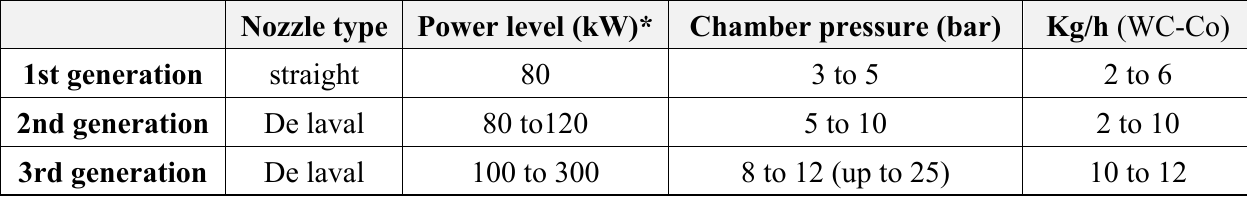
Table 1. The differences between three generations of HVOF